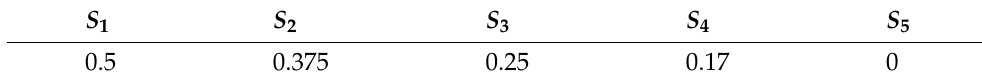
Table 5. α in different attacking scenarios.